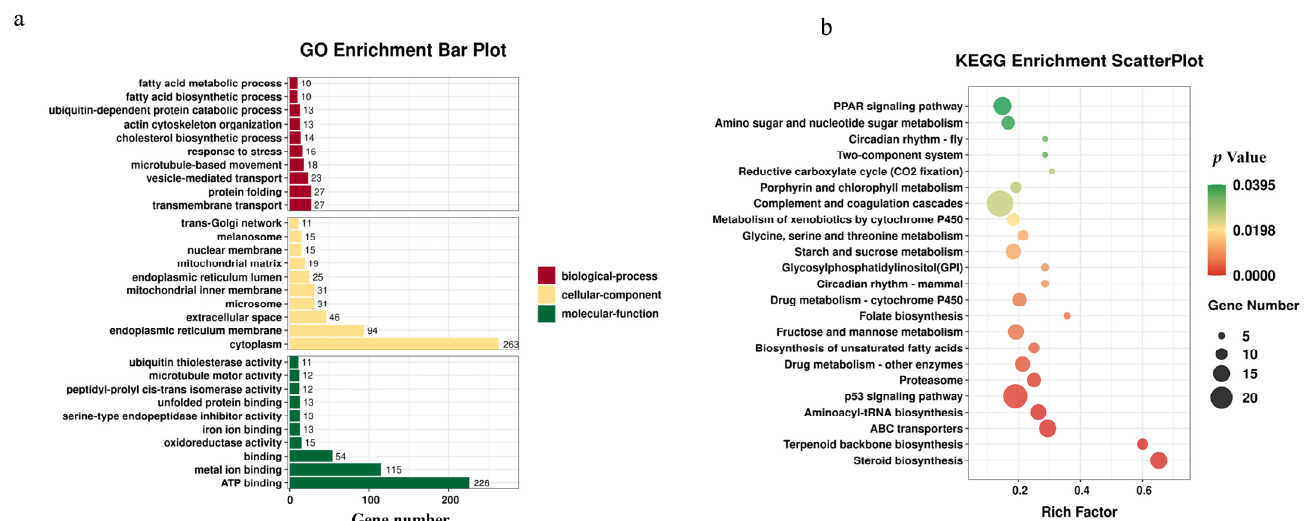
Figure 5. Functional and pathway annotations of DEGs between CON (control group) and AT2 (AGPAT2 -knock-down group). ( a ) Gene Ontology terms significantly enriched with DEGs in the molecular function, cellular component, and biological process categories; ( b ) top 23 KEGG pathways significantly enriched with DEGs.